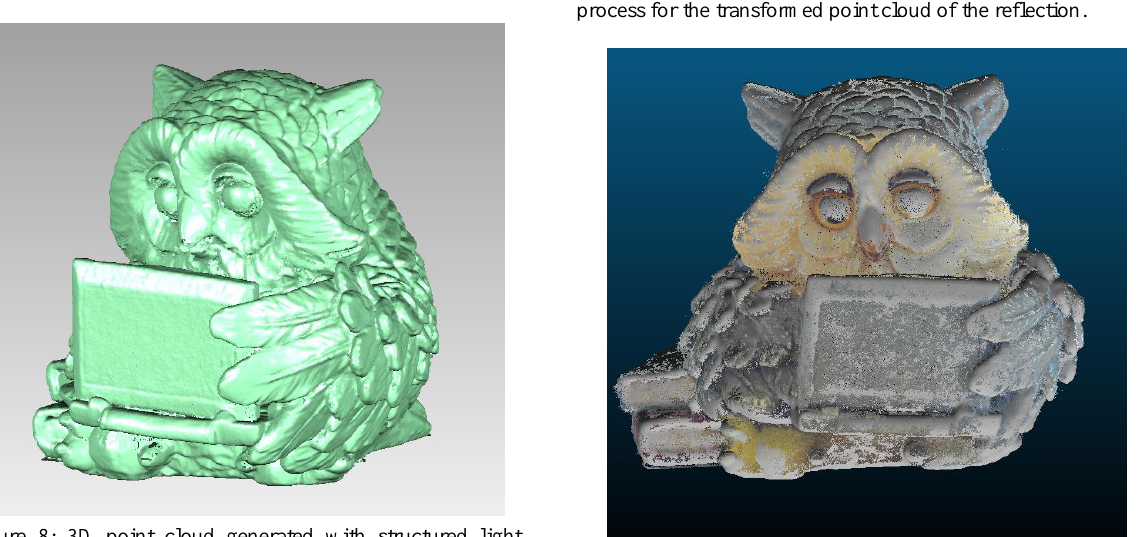
Figure 10: Successful alignment process between reflection and SL point